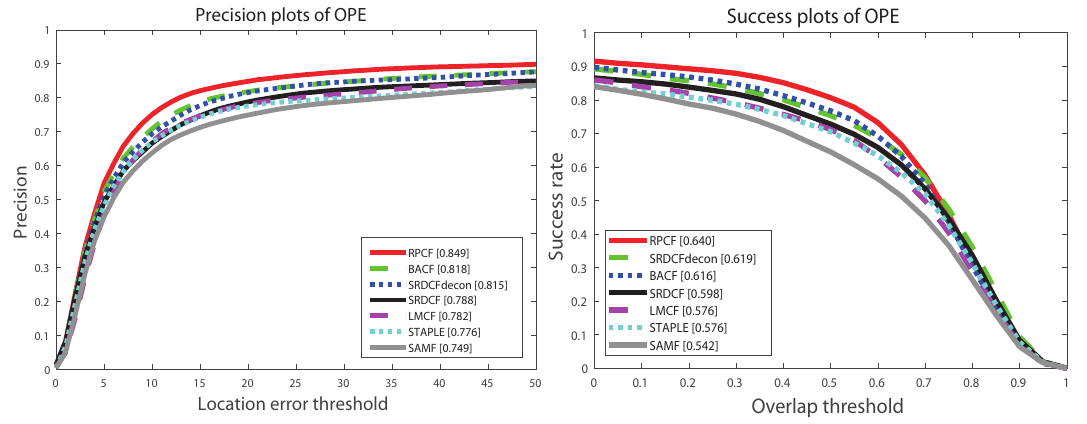
Figure 7. OTB2015 results of related trackers.